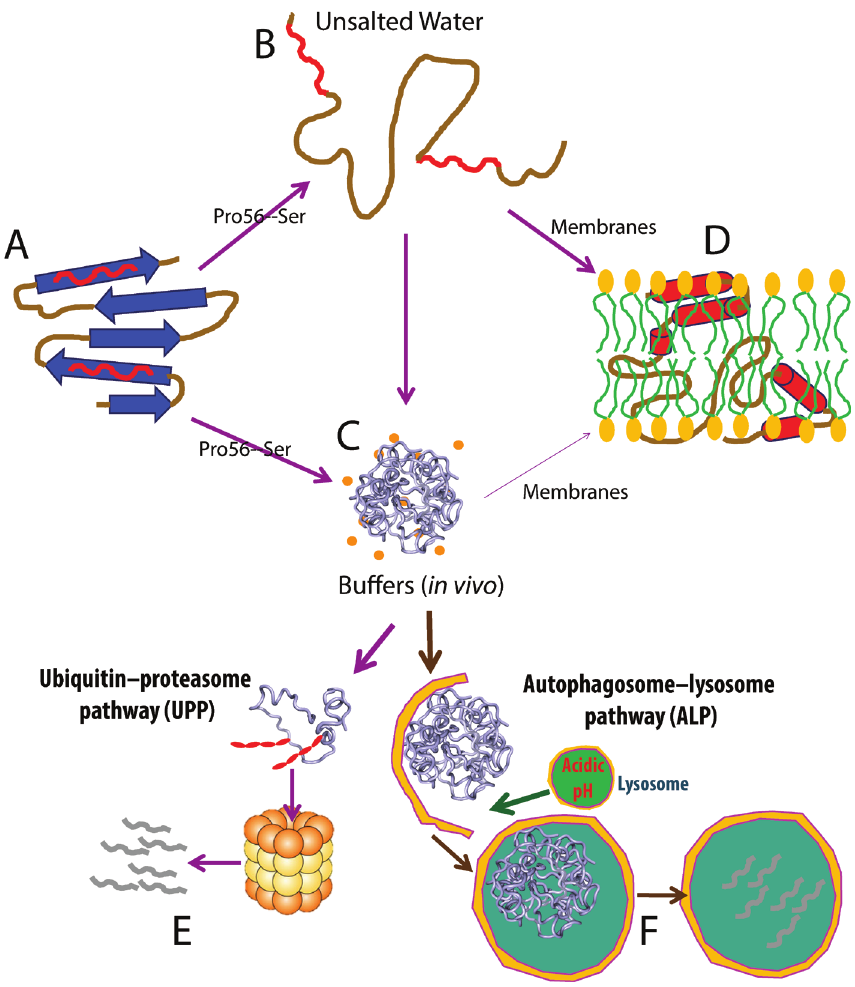
Figure 6. Mechanism for the chameleon transformation and partition into membranes. A . The wild-type protein domain like MSP adopts a well-folded three-dimensional structure and therefore its intrinsic amphiphilic and other hydrophobic patches are locked and shielded from being accessible to bulk solvent, thus being highly-soluble in salted aqueous solution. B . Some mutations on a well-folded protein like the ALS-causing P56S one are sufficient to completely eliminate its native fold. This results in improper exposure of the intrinsic amphiphilic and other hydrophobic patches. The protein then becomes only soluble but unstructured in unsalted aqueous solution, but is aggregated in vivo with ~150 mM ion concentrations ( C ). D . The unstructured mutant acquires the ability to spontaneously partitions into membranes driven by hydrogen bond energetics resulting from forming an amphiphilic helix. As we have shown that insoluble proteins are only insoluble in buffers but soluble in unsalted aqueous solution, even the aggregated mutant is able to partition into the membrane upon having access to membranes under some conditions. However, under normal physiological conditions, aggregates may be immediately detected and subsequently removed by different degradation machineries including ubiquitin-proteasome ( E ) or/and autophagosome-lysosome ( F ) pathways. However, once these machineries become dysfunctional due to aging, or/and are inhibited by abnormal conditions, which are generally found to trigger neurodegenerative diseases, aggregates may get become accumulated, which may increase the chance of them accessing/attacking